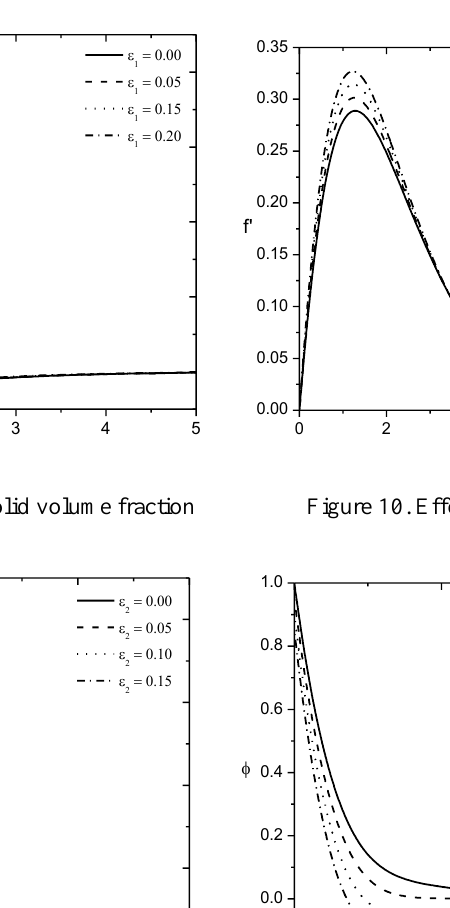
 on the Temperature Figure 12. Effet of Figure 11. Effet of 2